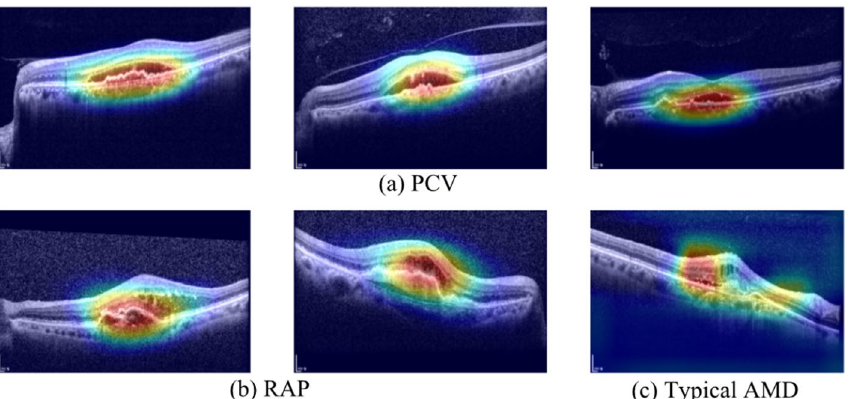
Figure 3. Visualization of 6 cases of AMD subtypes (3 PCV cases, 2 RAP cases, 1 Typical AMD cases) using Grad-CAM on our deep learning model. ( a ) Three PCV cases, ( b ) Two RAP cases, ( c ) One Typical AMD case. The high intensity area (red and yellow color) reflects the area of interest to our model. The six images used in this figure were correctly classified by two retina specialists and our model, but six or more ophthalmologists were misclassified. The corresponding Grad-CAM image shows that our model actually showed the similar criteria for classifying AMD